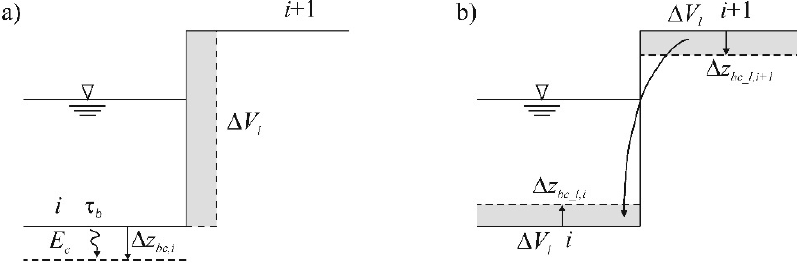
Figure 2. Sketch of the methodology used to evaluate the lateral erosion process: ( a ) bank retreat due to the fall of volume Δ V l , and ( b ) schematization of the process adopted in the present model.